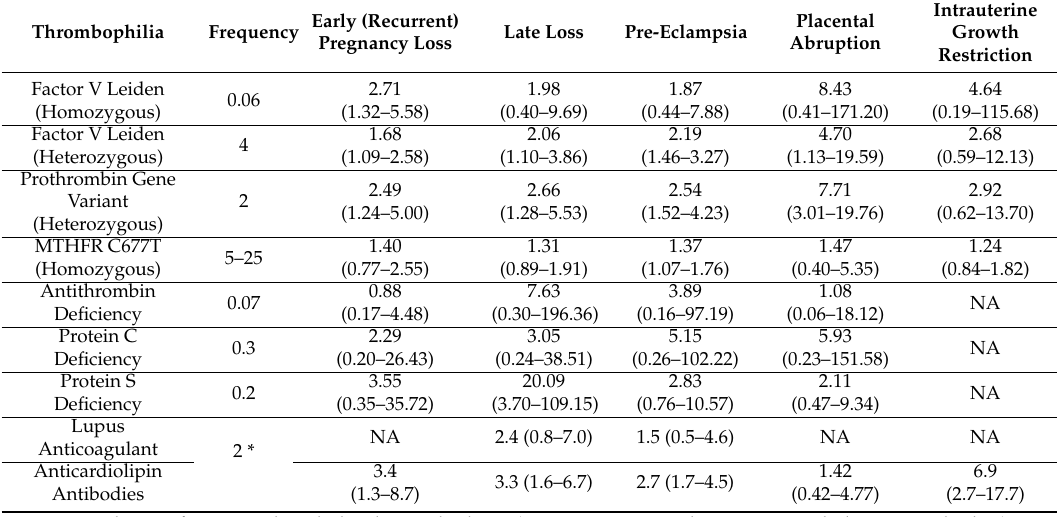
Table 1. Association between Thrombophilia and Pregnancy